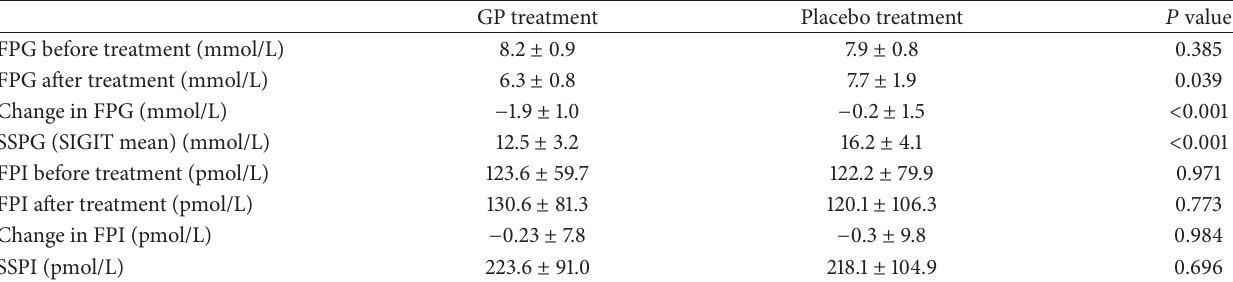
Table 2: Plasma glucose, insulin levels, and SIGIT mean in two kinds of treatment. GP treatment Placebo